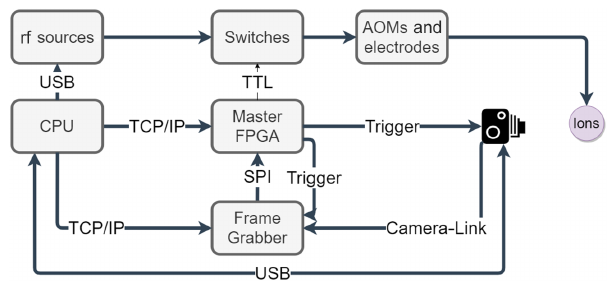
FIG. 8. The control scheme for the quantum coherent feedback module. The user controls the experiment using the CPU, which through the USB determines the parameters for the rf sources and the camera and via TCP/IP uploads the detection parameters to the frame-grabber field-programmable gate array (FPGA) and an experimental sequence onto the main FPGA. Once